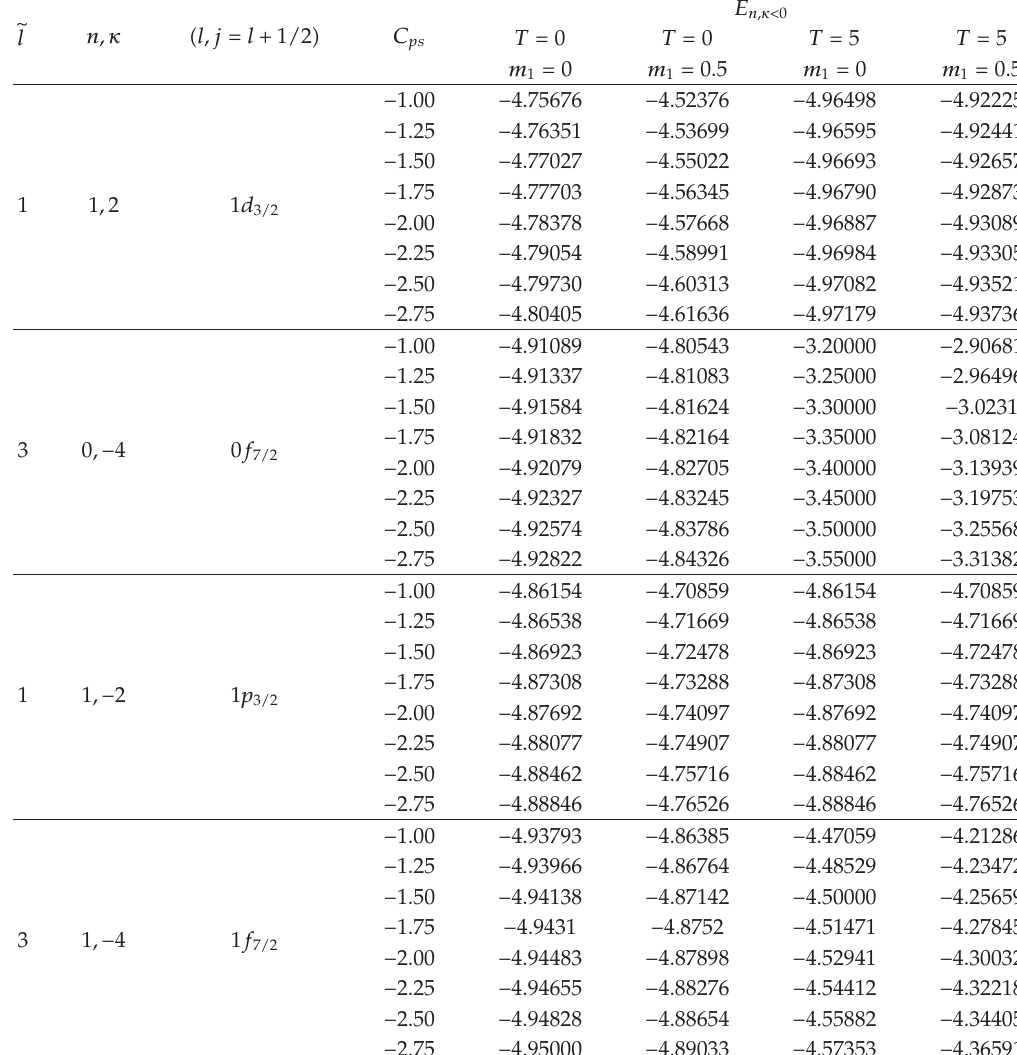
Table 3: The bound state energy eigenvalues of the Coulomb potential for several states under the pseudo- spin symmetry limit with values of C ps with m 0 (cid:5) 5 . 0fm − 1 , q (cid:5) 1 , (cid:2) (cid:5) c (cid:5) 1 , m 1 (cid:5) (cid:2) 0 , 0 . 5 (cid:3) , and T (cid:5) (cid:2) 0 , 5 (cid:3)